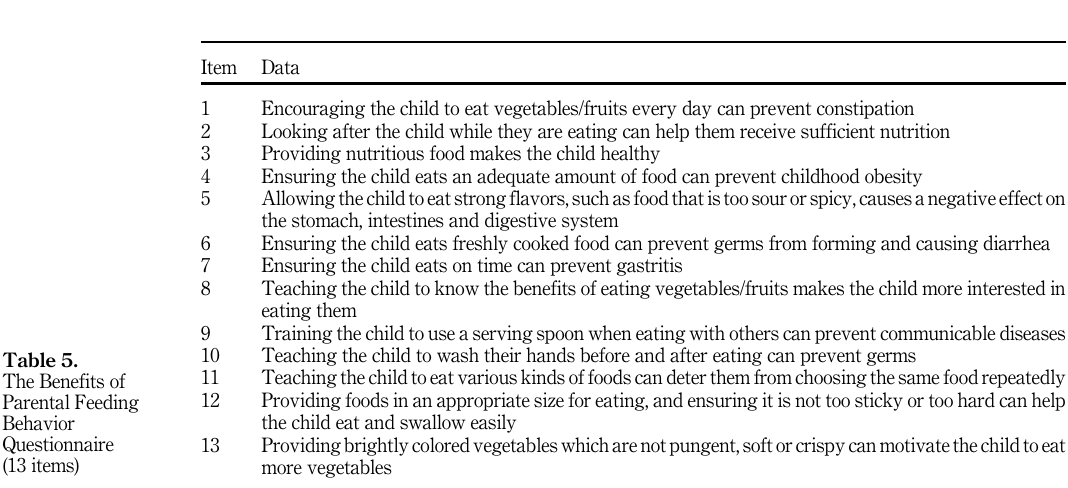
Figure 2. Standardized modified measurement model for the